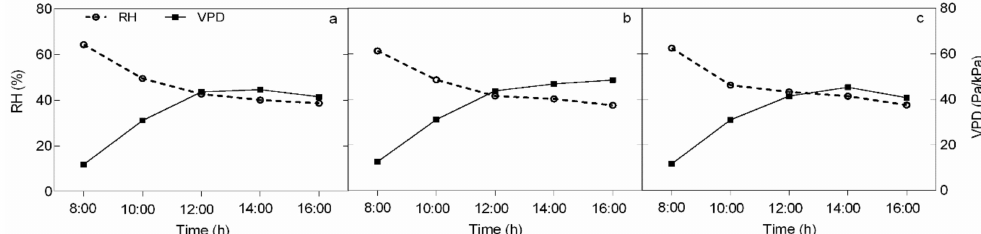
Figure 3. Diurnal variations in relative humidity (RH) and vapor pressure deficit (VPD) in 2014 ( a ), 2015 ( b ) and 2016 ( c ) recorded between 8:00 and 16:00 h. Symbols are: ( vapor pressure